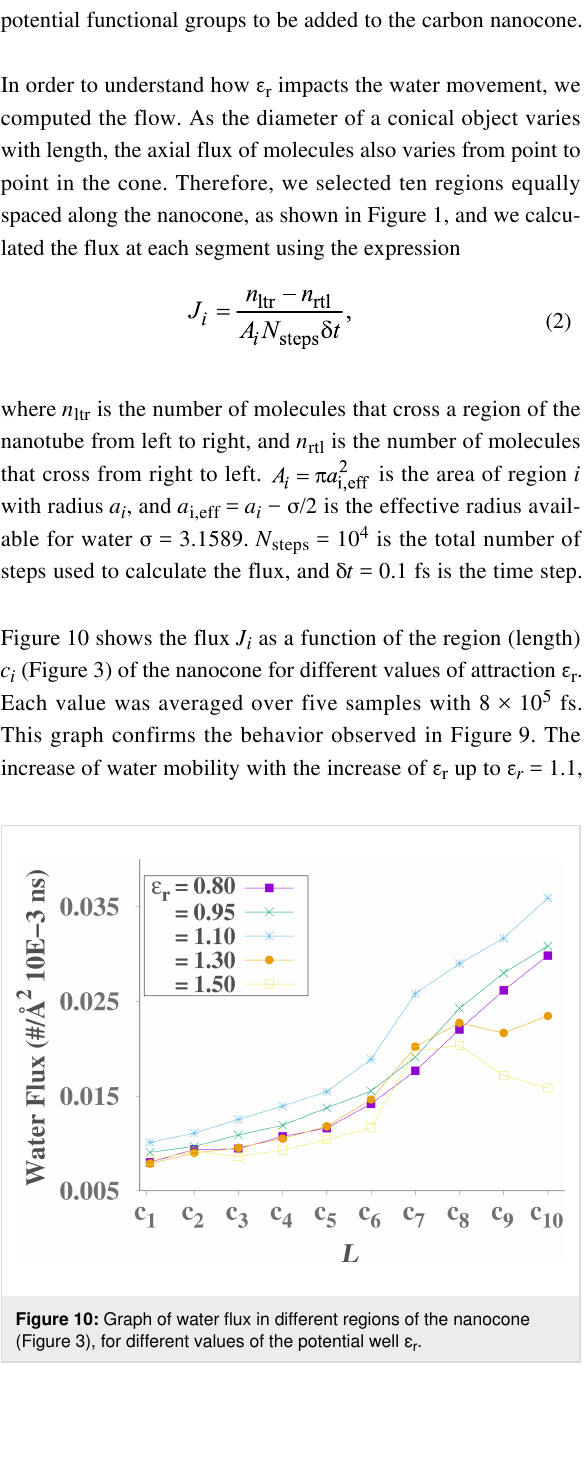
philic interaction with the rings is too strong, and water mole- cules tend to be stuck at the rings. The maximum rate occurs for